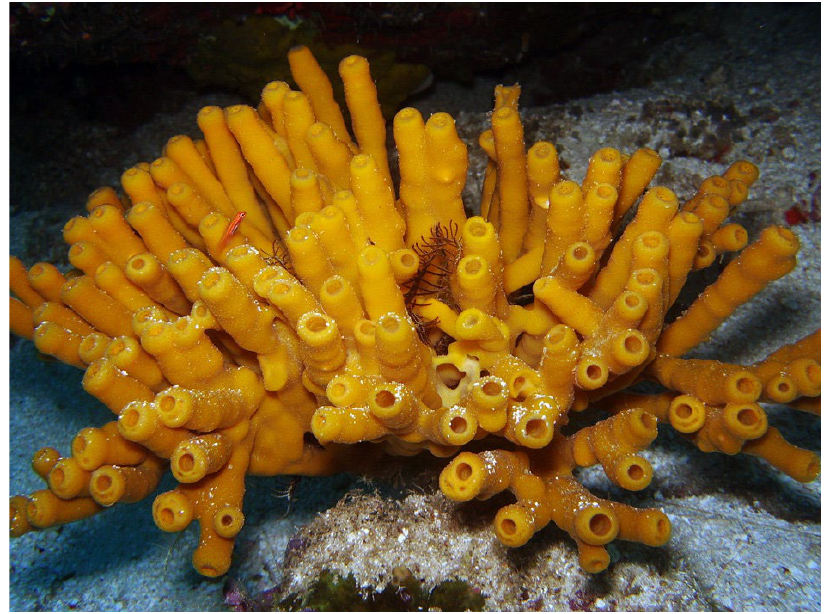
Figure 1. Calcareous sponges are depicted. Sponges are usually regarded as non-ordered biological objects. biological